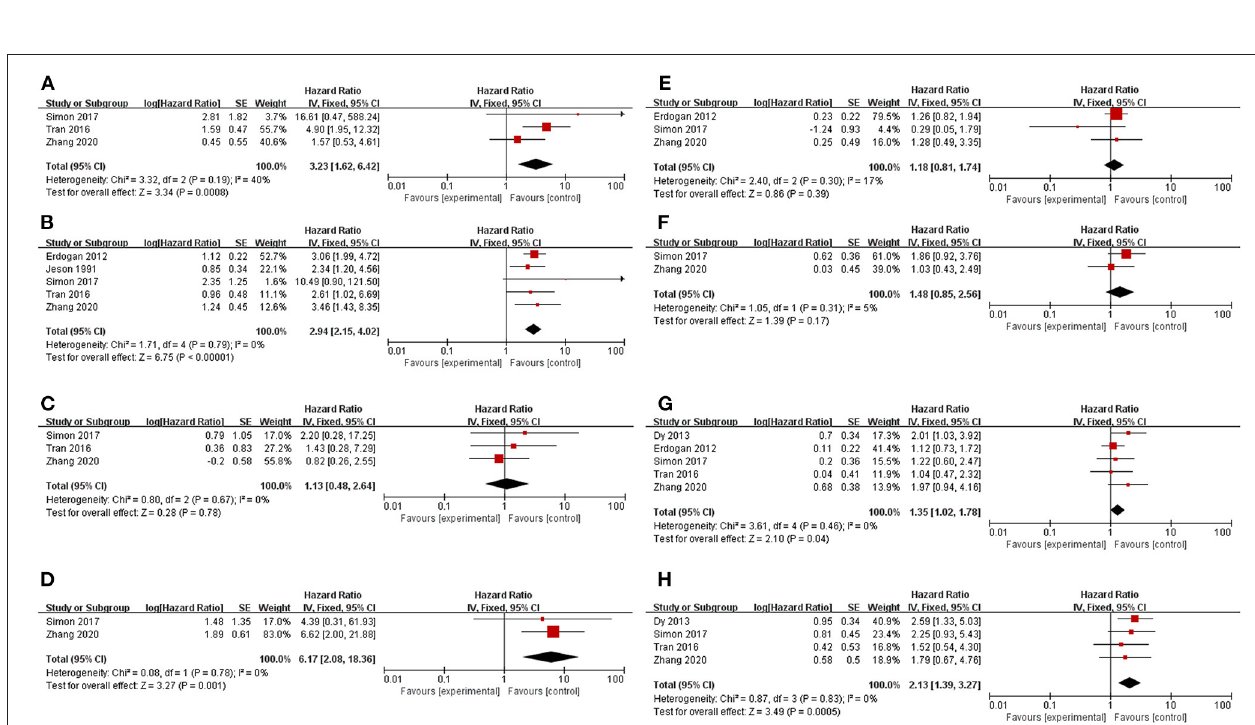
FIGURE 3 | Prognostic factors for recurrent ACC patients. (A) Multiple recurrence; (B) Disease-free interval < 12 months; (C) Relatively high Ki67 index; (D) Stage III–IV of original tumor; (E) Age; (F) Relatively large original tumor size; (G) Sex (male vs. female); (H) Initial R0 resection.